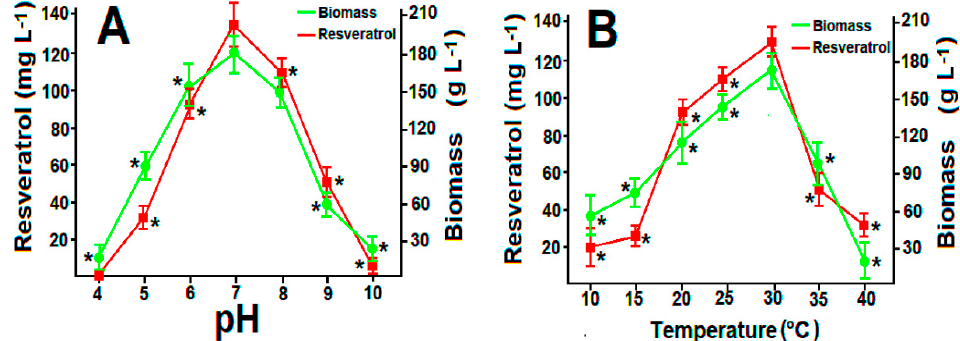
Figure 3. Effect of pH ( A ) and temperature ( B ) on the growth of A. aureus MaC7A and its RV production. * Indicates statically significant differences ( p < 0.05) for RV production and biomass compared with that of pH 7 and 30 °C. Error bars indicate SD (n = 10).